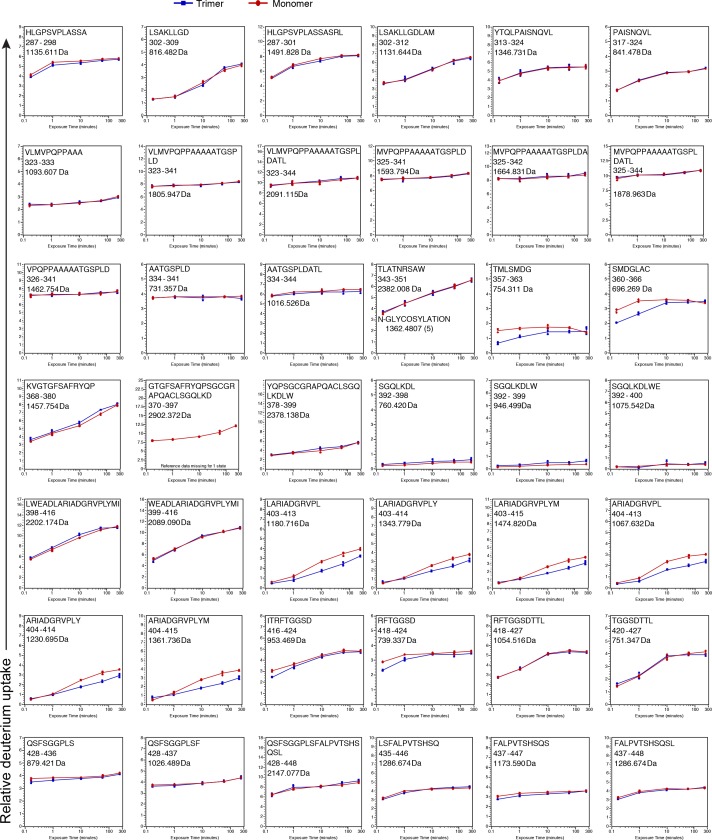
See legend for Figure 2—figure supplement 3 .